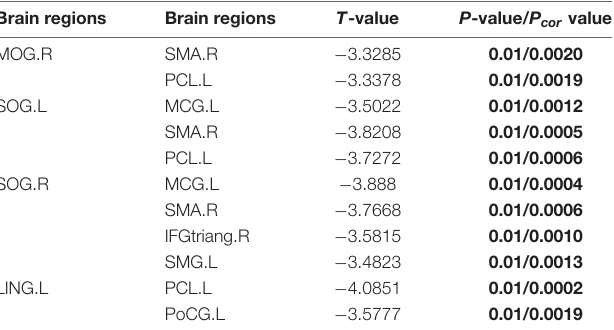
TABLE 3 | Significantly decreased functional connectivities in patients with iRBD compared with HCs. Brain regions Brain regions T -value P -value /P cor